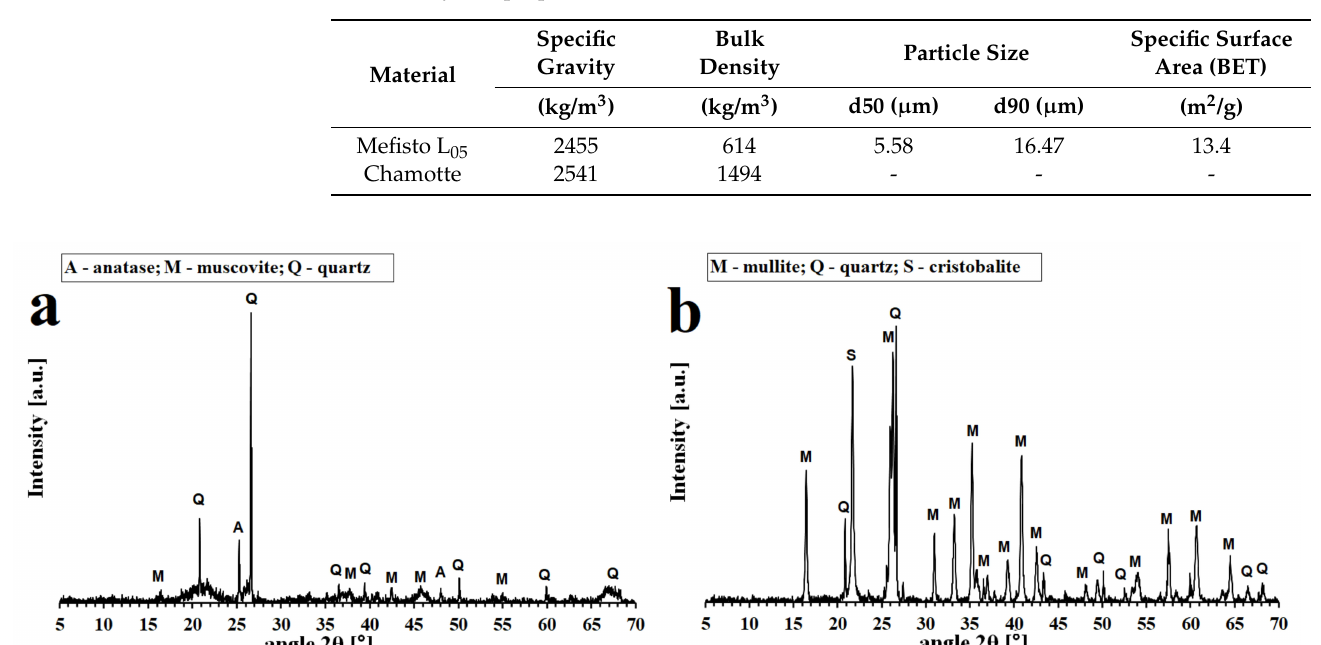
Figure 1. XRD patterns of the aluminosilicate Mefisto L 05 ( a ) and chamotte ( b